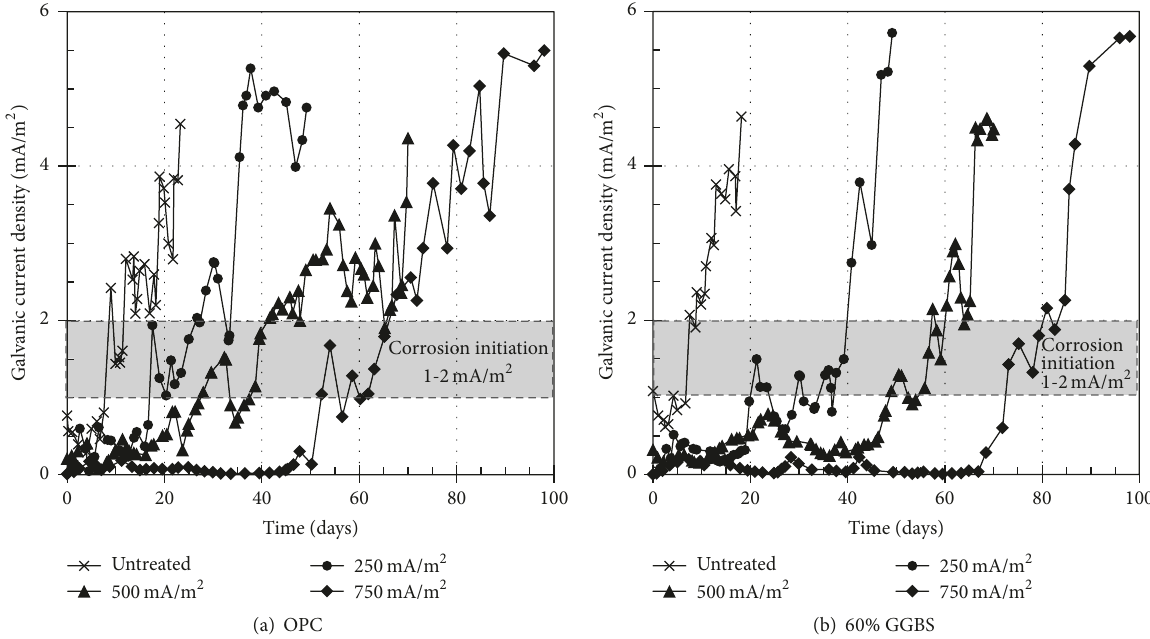
Figure 2: Galvanic current densities of steel in concrete after electrochemical treatment of 0, 250, 500, and 750 mA/m 2 for 4 weeks depending on OPC (a) and GGBS (b).